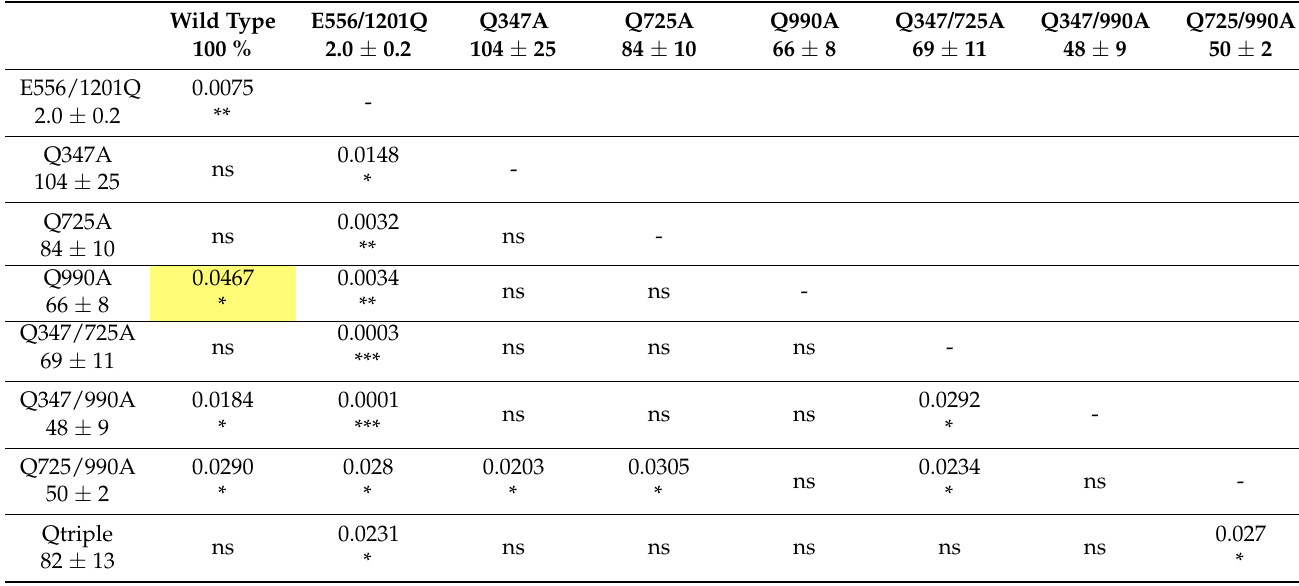
Table A3. Functionality of mutants for the transport of OREGON-GREEN taxol bisacetate normalized to the wild-type transporter activity and pairwise statistical comparison of the raw